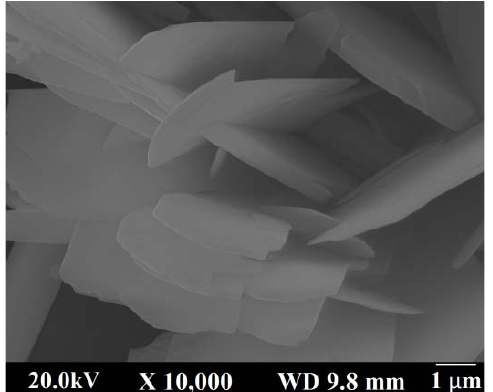
Figure 14. SEM image of the obtained material. Brushite synthesized at 75 °C with a flow rate of 250